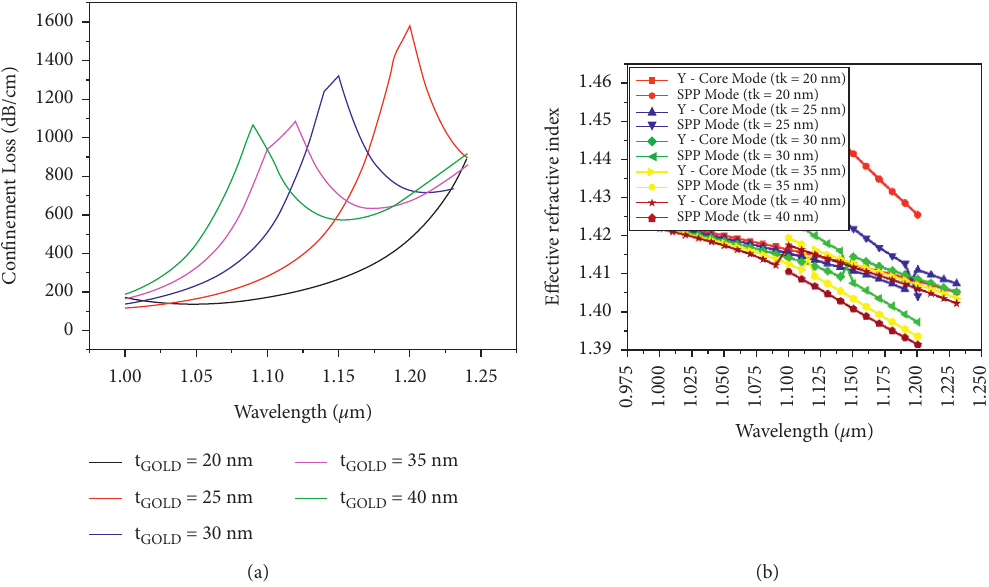
Figure 5: Differences in the loss spectra for the filter model with varied t